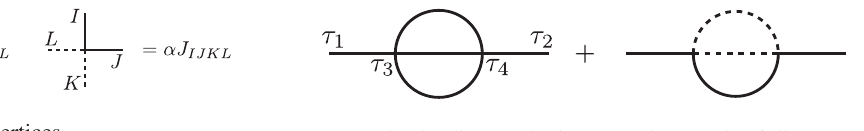
FIG. 3. Interaction vertices. FIG. 4. The leading melonic correction to the full two-point function G 11 .